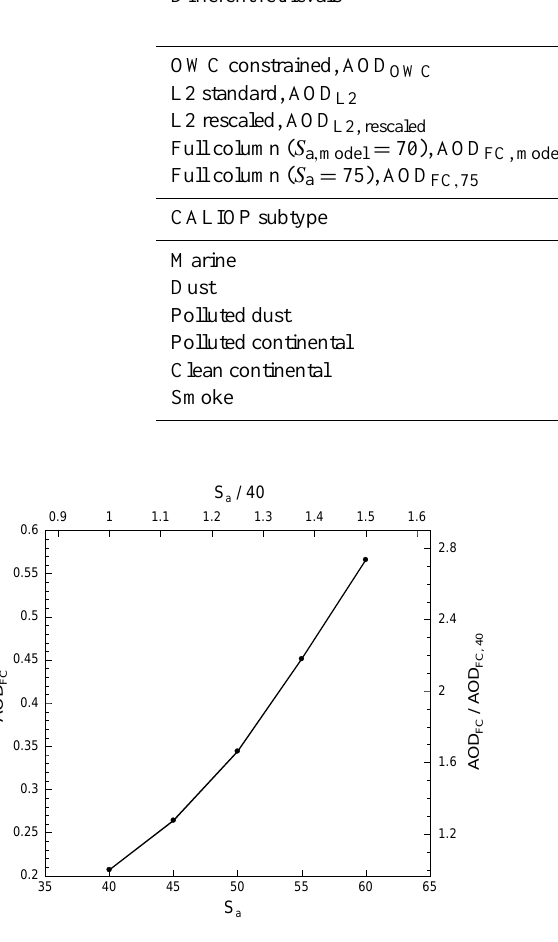
Figure 14. Mean AOD FC as a function of S a derived from the full column retrievals shown in Fig.